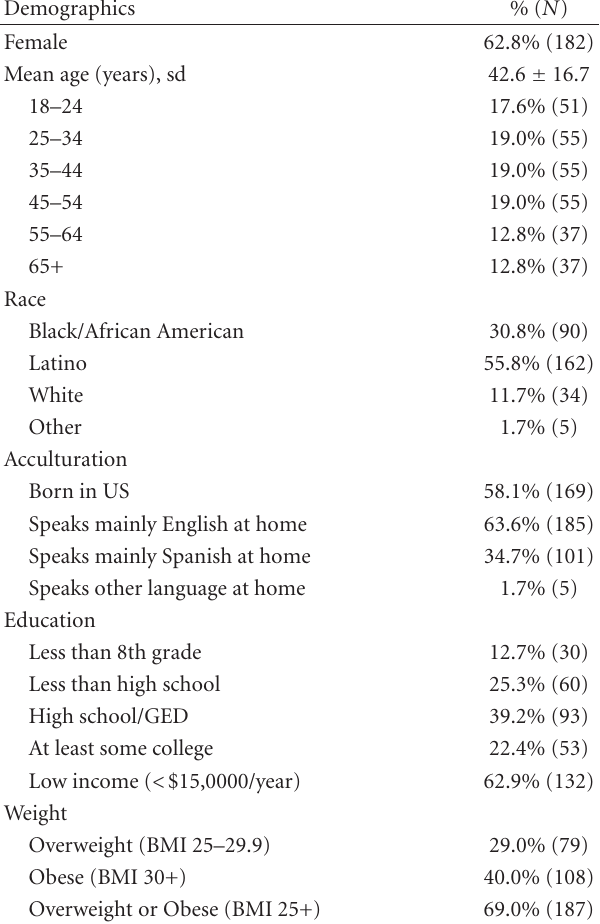
Table 1: Sociodemographic characteristics of the survey respon-